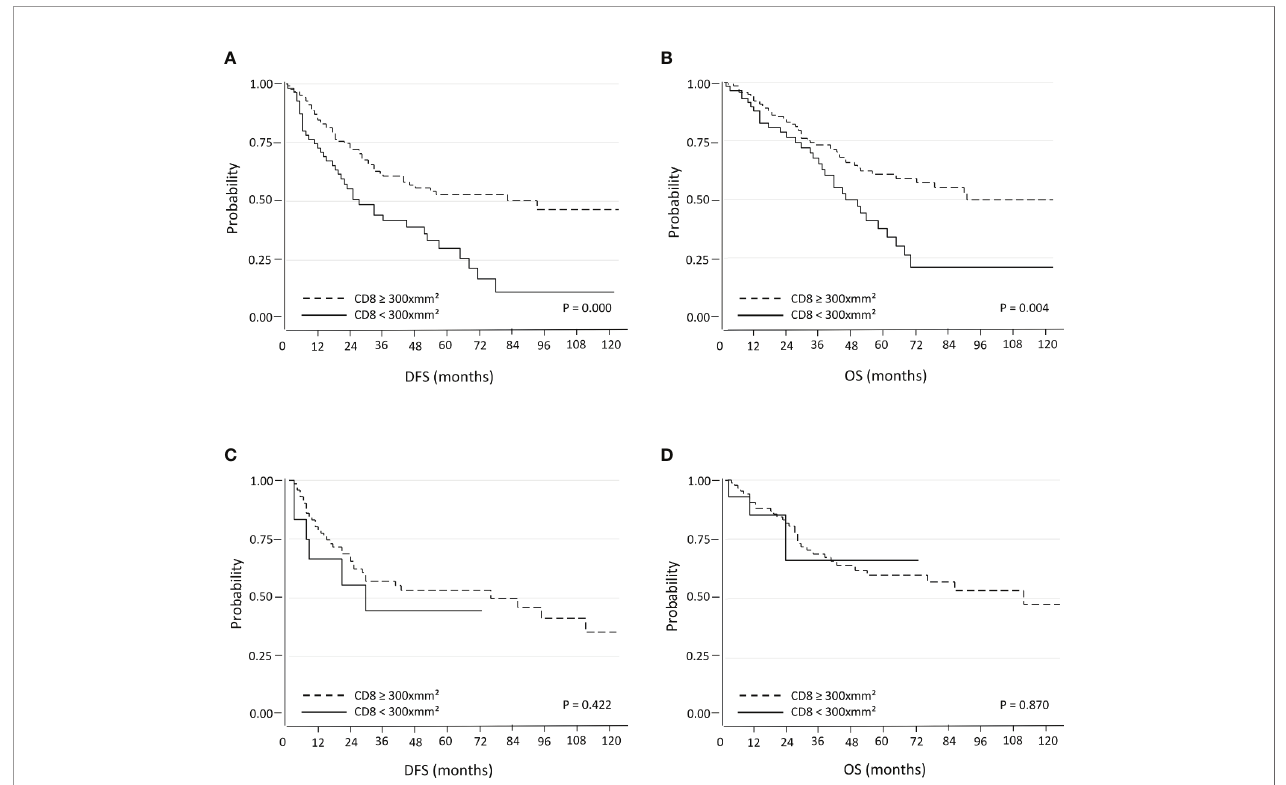
FIGURE 2 | Kaplan-Meiercurvesfor DFSandOSbasedonCD8 + TILsusing the25 th percentileasthethresholdinPD-L1negative (A, B) andPD-L1positive (C, D)